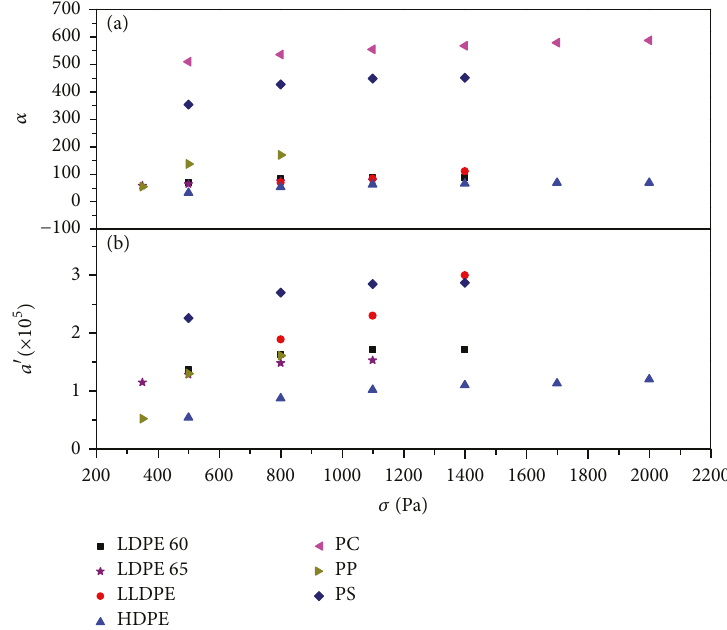
Figure 8: The elongational stress dependency of computed parameters 𝛼 and 𝑎 󸀠 calculated by (7) and (8).